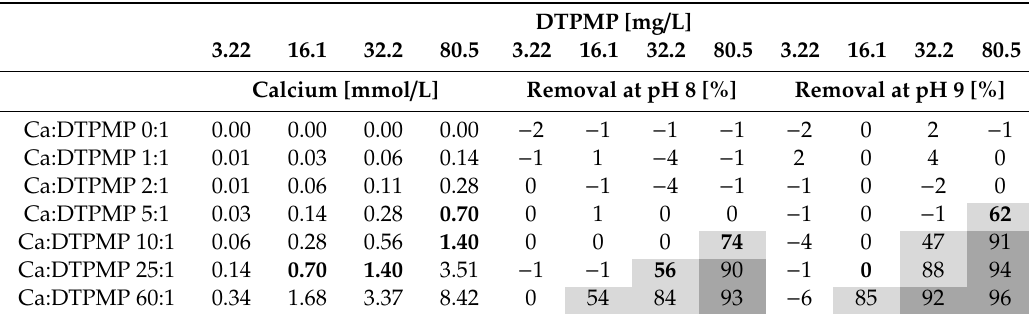
Table 5. Removal of DTPMP by precipitation at di ff erent calcium concentrations and pH values (T = 20 ◦ C; t = 7 d; no GFH added). Standard deviations are shown in Table c